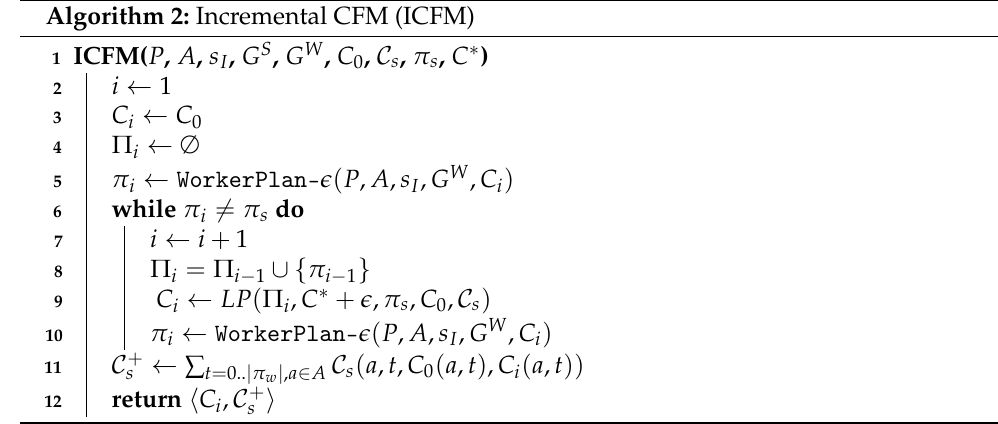
Algorithm 2: Incremental CFM